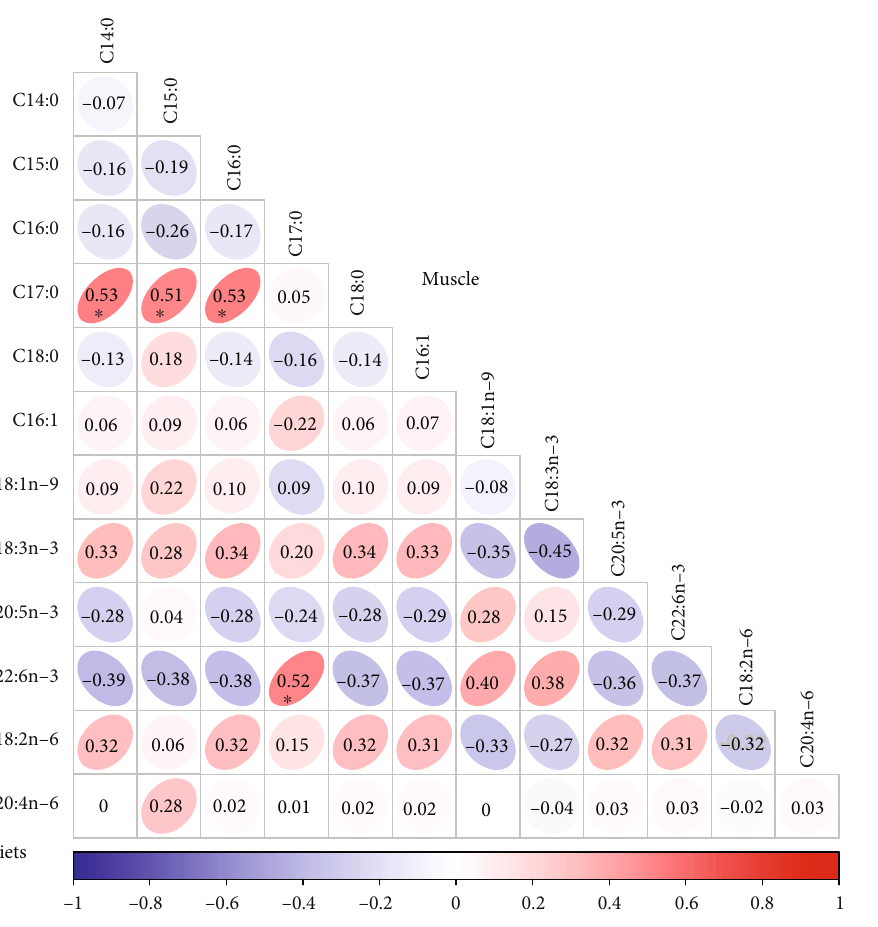
Figure 2: The correlation between the fatty acid compositions in tail muscle and diets by Pearson correlation matrix analysis. The color scale indicates the correlation value from − 1 to 1. The red color indicates a positive correlation. The blue color indicates a negative correlation. ∗ Signi fi cant di ff erence ( P < 0 : 05